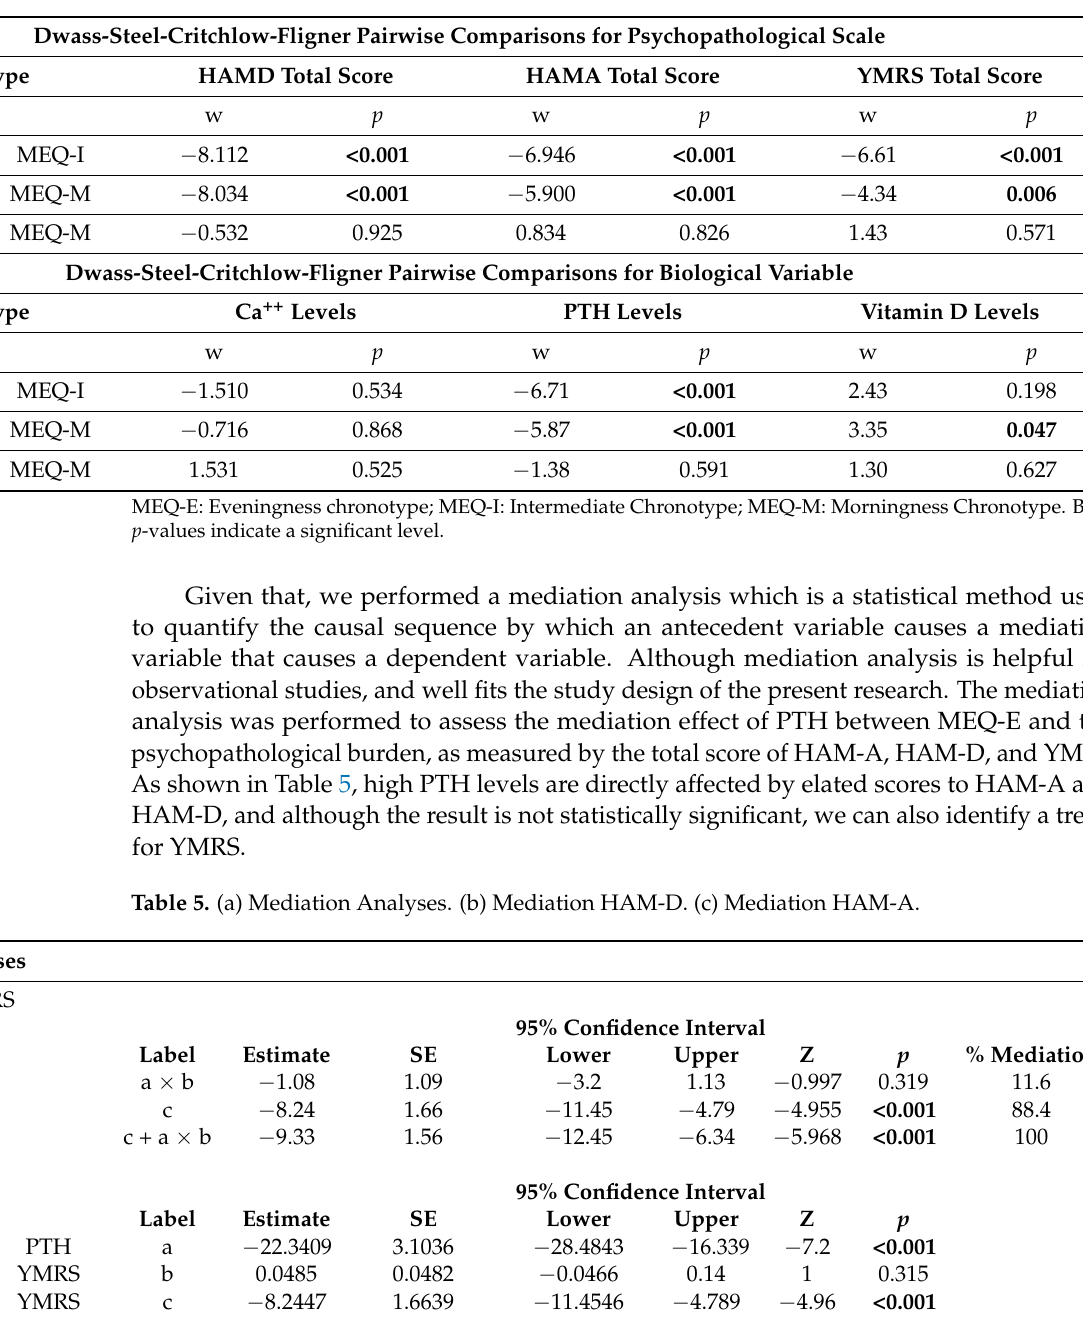
Table 4. Dwass-Steel-Critchlow-Fligner pairwise comparisons.